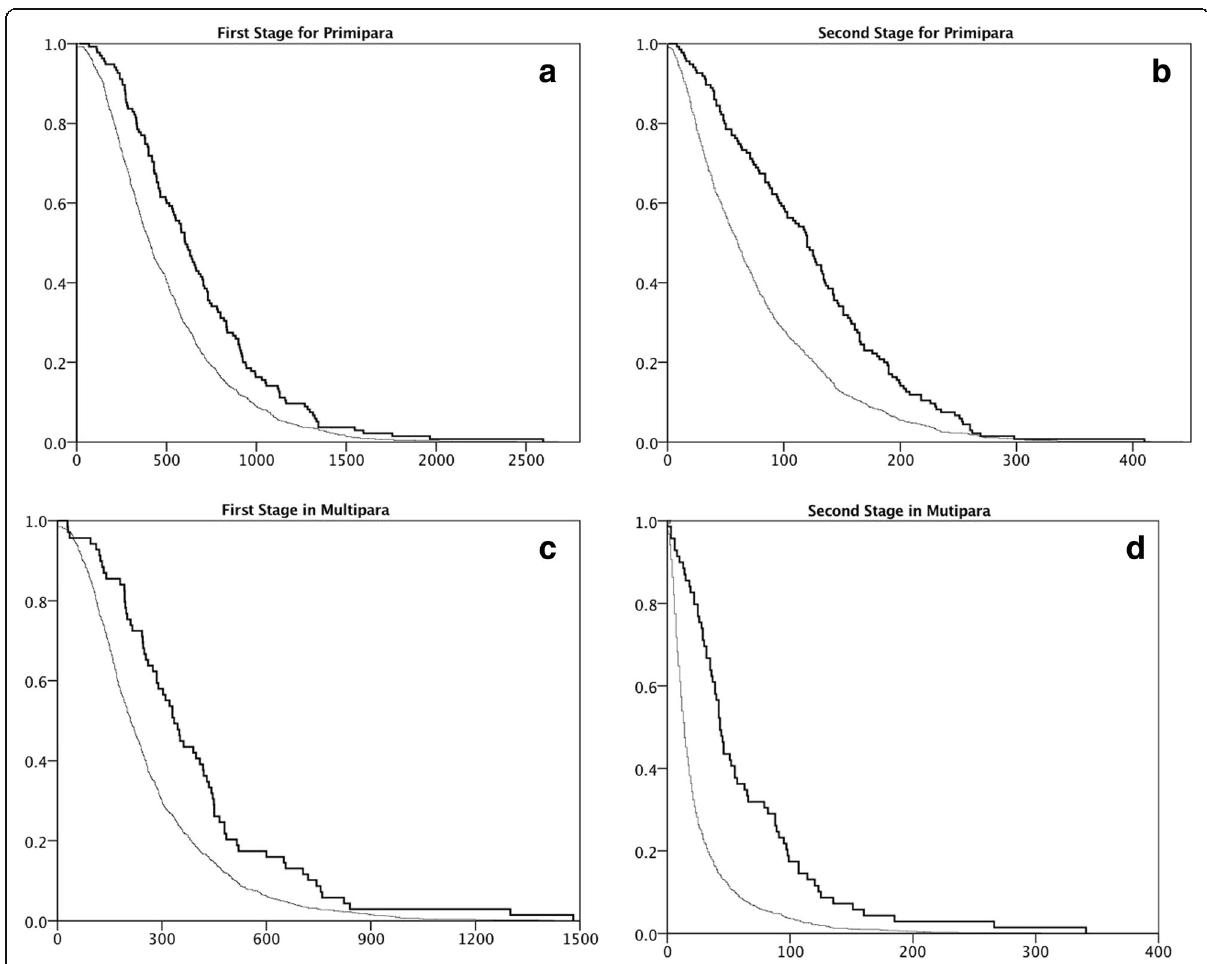
Fig. 2 Each panel shows the Kaplan – Meier Curve for the first stage of labor for primipara ( a ), second stage for primipara ( b ), first stage for multipara ( c ), and second stage for multipara ( d ). The difference in the average time between the EL and NEL group was statistically significant between two groups compared with log-rank test ( p < 0.01)